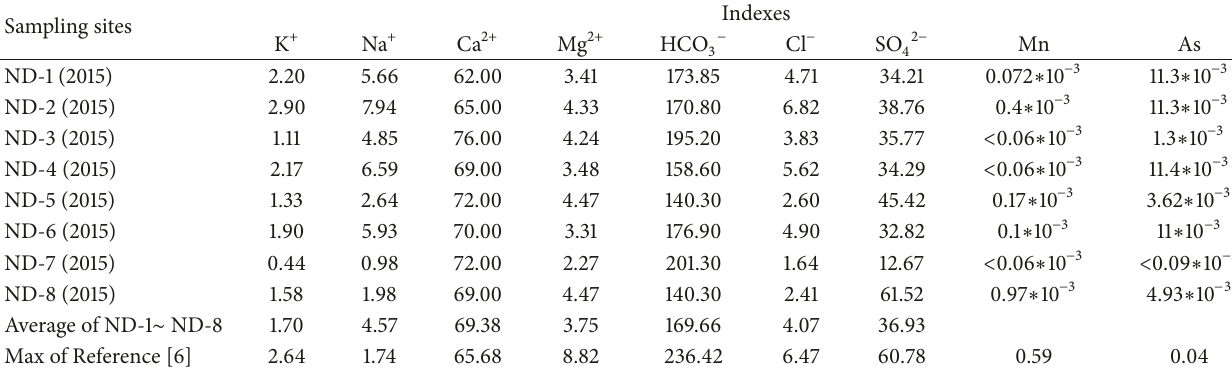
Table 3: Comparison of the main indexes in the Lihu subterranean river basin (mg.L − 1). Sampling sites